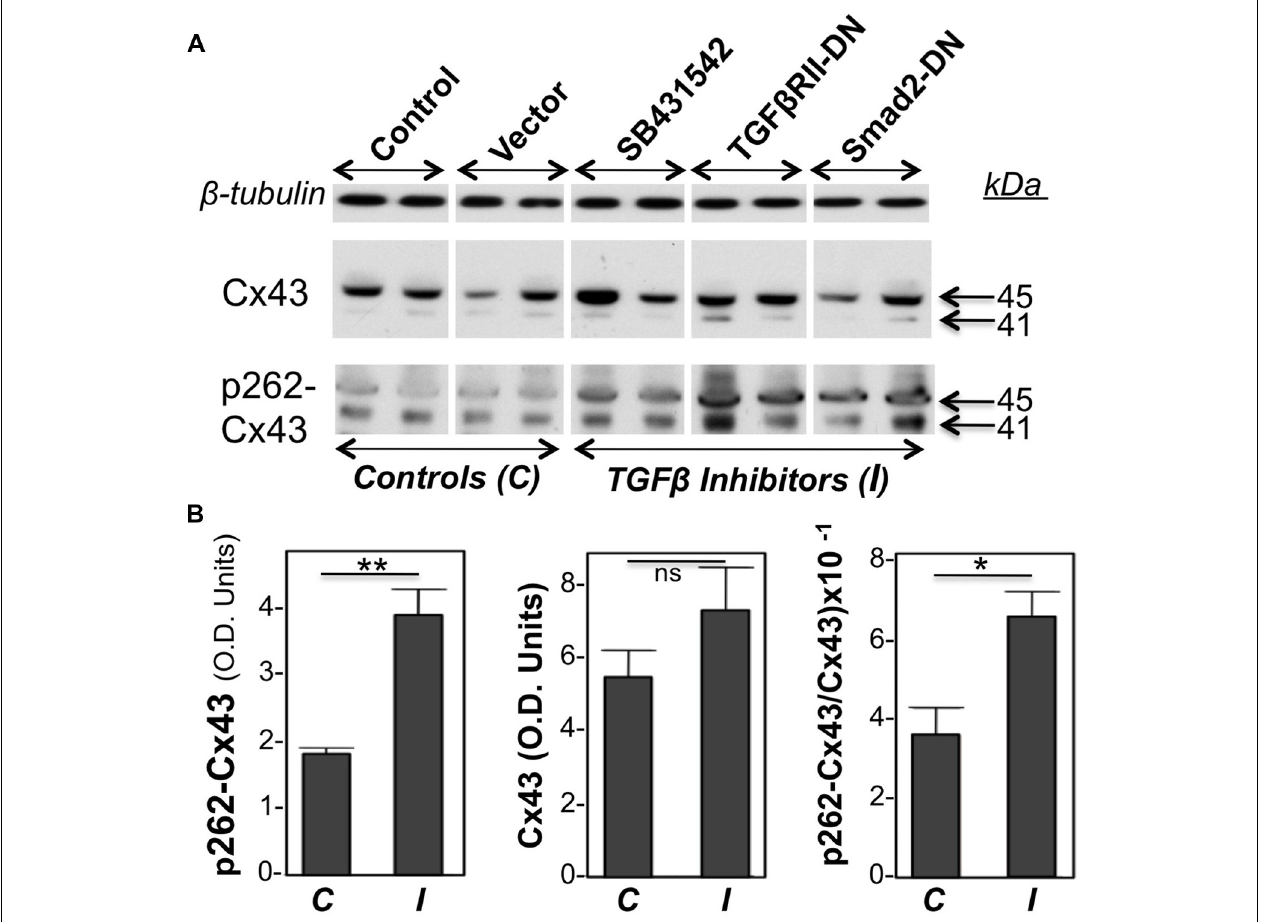
FIGURE 1 | Inhibition ofTGF β signaling increases baseline cardiomyocyte Cx43 phosphorylation at S262. (A) Western blots of cardiomyocyte lysates probed for total Cx43 (Cx43), pS262-Cx43, and β -tubulin (loading control), as indicated. Samples shown represent five groups, including two types of controls (C) , such as myocytes subjected to no treatment (Control), or exposed to an empty adenoviral vector (Vector); the two controls produced similar data.The remaining three groups were treated withTGF β signaling